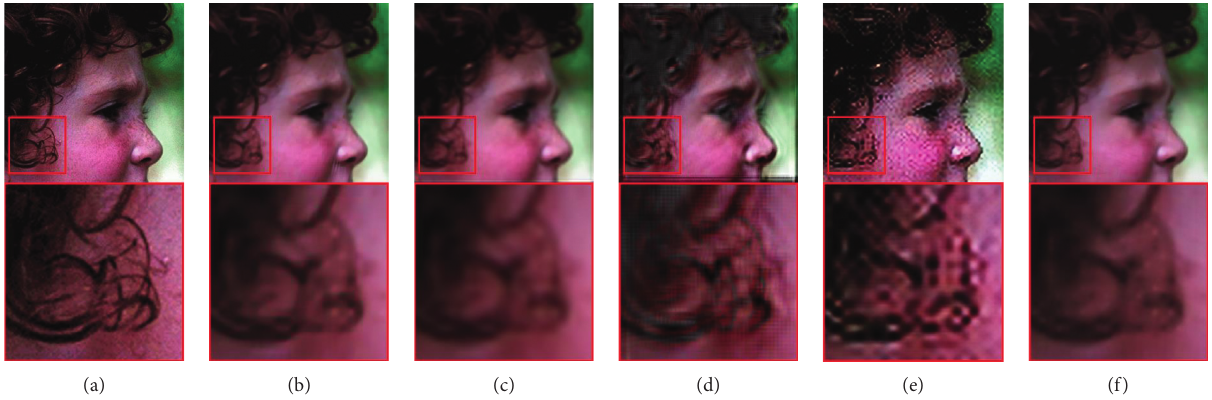
Figure 10: Super-resolution results of the “girl” image with magnification factor 4: (a) original high-resolution image; (b) result reconstructed by SRCNN; (c) result reconstructed by FSRCNN; (d) result reconstructed by SRGAN; (e) result reconstructed by RDN; (f) result reconstructed by our method.